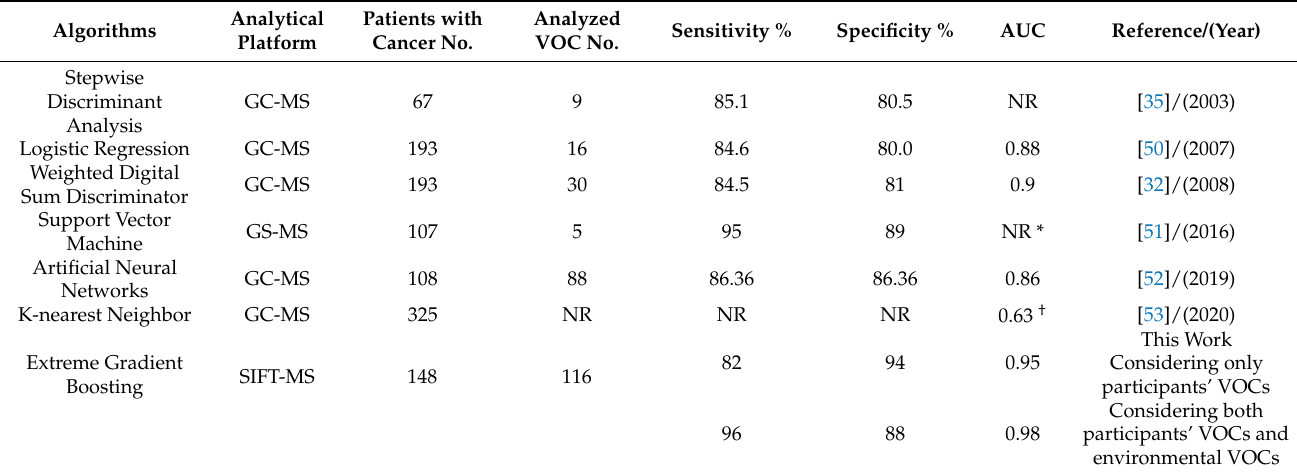
Table 3. Summary of various algorithms applied to lung cancer diagnosis using multiple